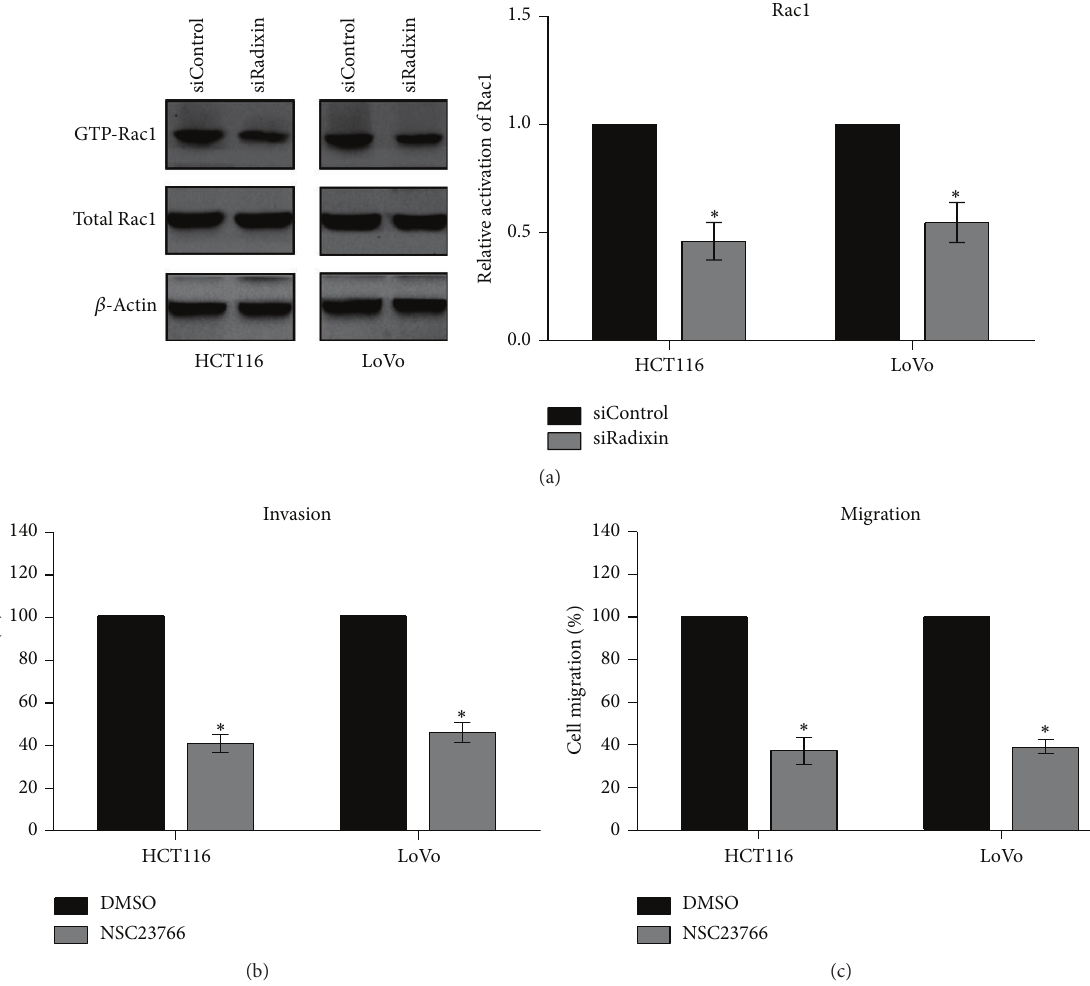
Figure 4: Radixin enhanced the invasion and migration of HCT116 and LoVo cells through Rac1 activation. (a) Cells were transfected with either control siRNA or radixin siRNA for 48 h. Then the amount of GTP binding protein Rac1 was analyzed by Rac1 activity assay kit. (b) and (c) Cells were pretreated with NSC23766 or DMSO for 1 h and then were subjected to invasion and migration assays. ∗ 𝑃 < 0.05